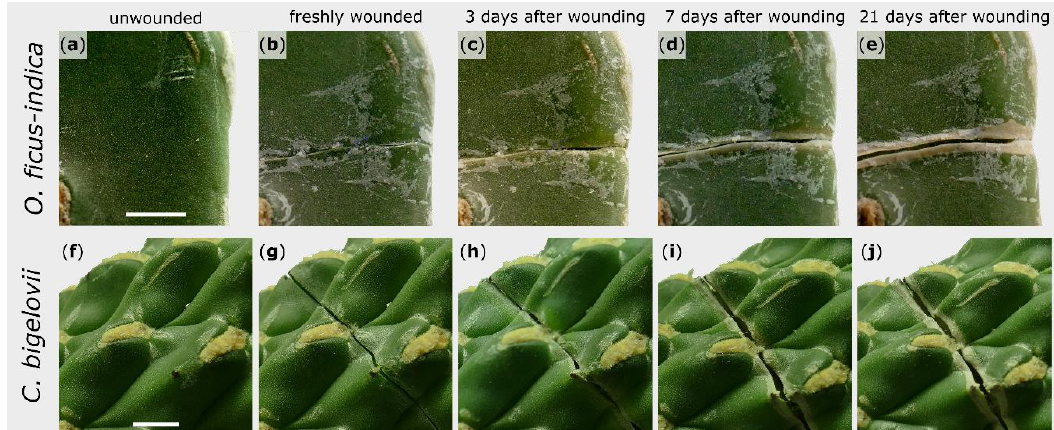
Figure 1. Morphological wound analysis of Opuntia ficus-indica (upper images) and Cylindropuntia bigelovii (lower images). The same section of one branch per species is presented in an unwounded condition ( a , f ), immediately after wounding ( b , g ), and after a healing phase of 3 days ( c , h ), 7 days ( d , i ), and 21 days ( e , j ). Scale bars = 5 mm.